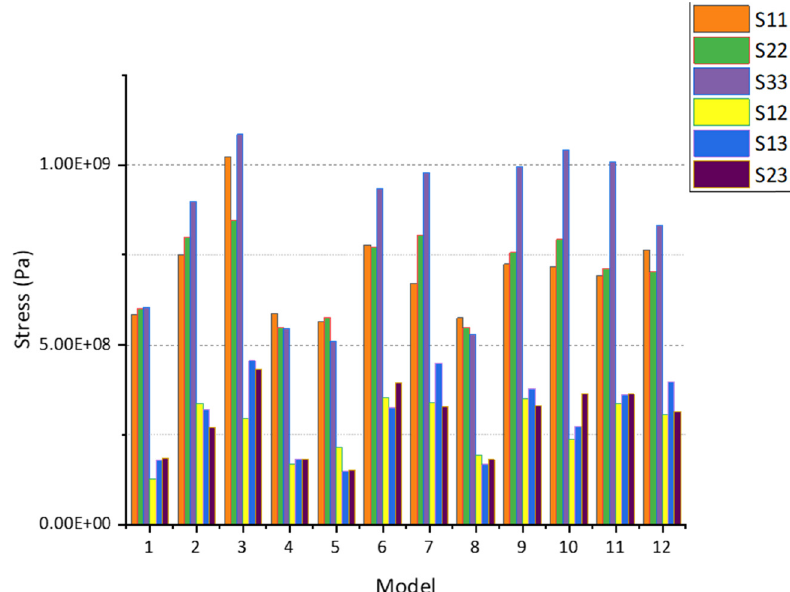
Figure 8: Average stress value every